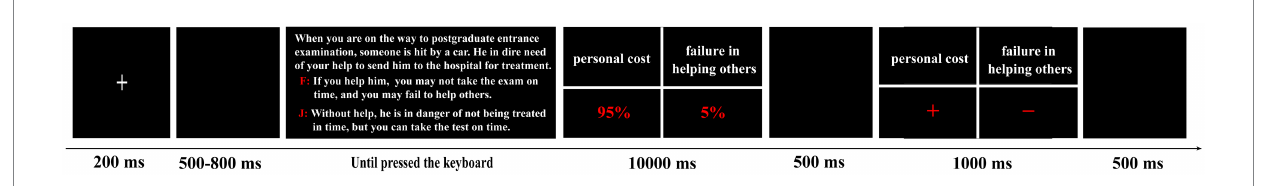
FIGURE 3 The sequence of a single trial during PRB under different levels and types of